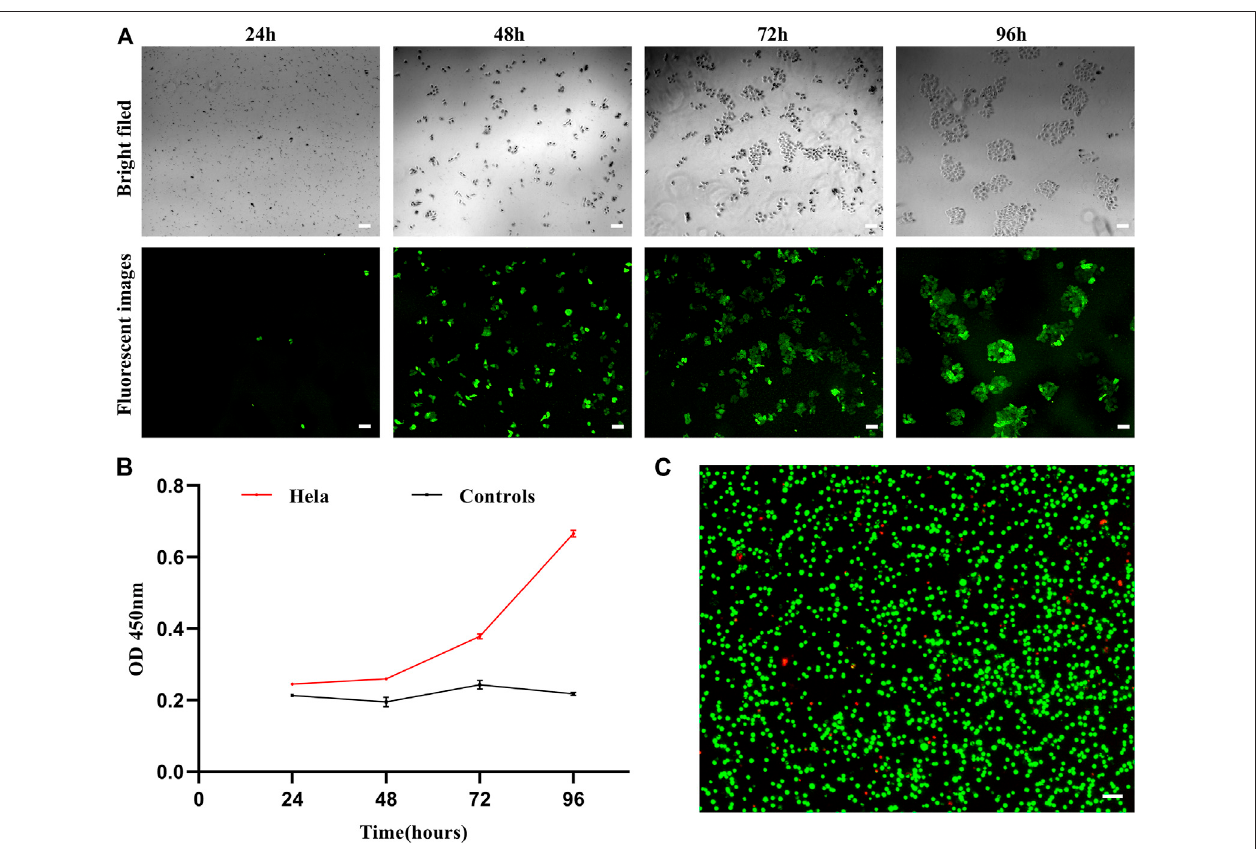
FIGURE7|(A) Bright fi eldand fl uorescentimagesofHeLacellsfollowingdualantibody-modi fi ednanoparticle-mediatedcaptureandsubsequentculturefor24,48, 72,or96 h. (B) Absorbance (OD)at450 nmforHeLacellculturesfollowingdualantibody-modi fi ednanoparticle-mediatedcapture. (C) FluorescentimagingofHeLacell viability following nanoparticle-mediated capture. Scale bar: 100 μ